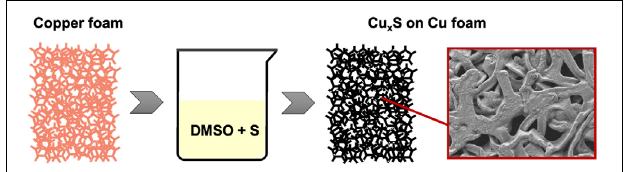
FIGURE 1 | Copper sulfide on Cu foam synthesis route